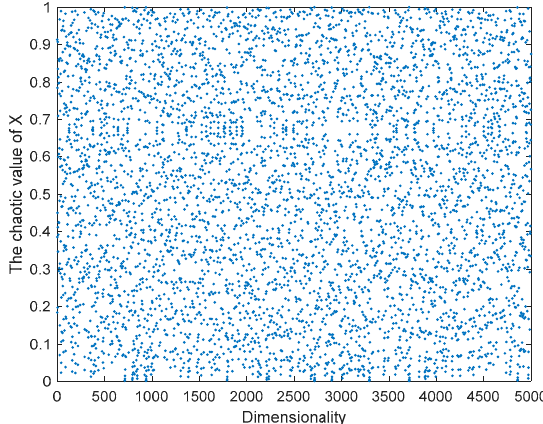
Figure 4. Distribution of improved logistic chaos values.